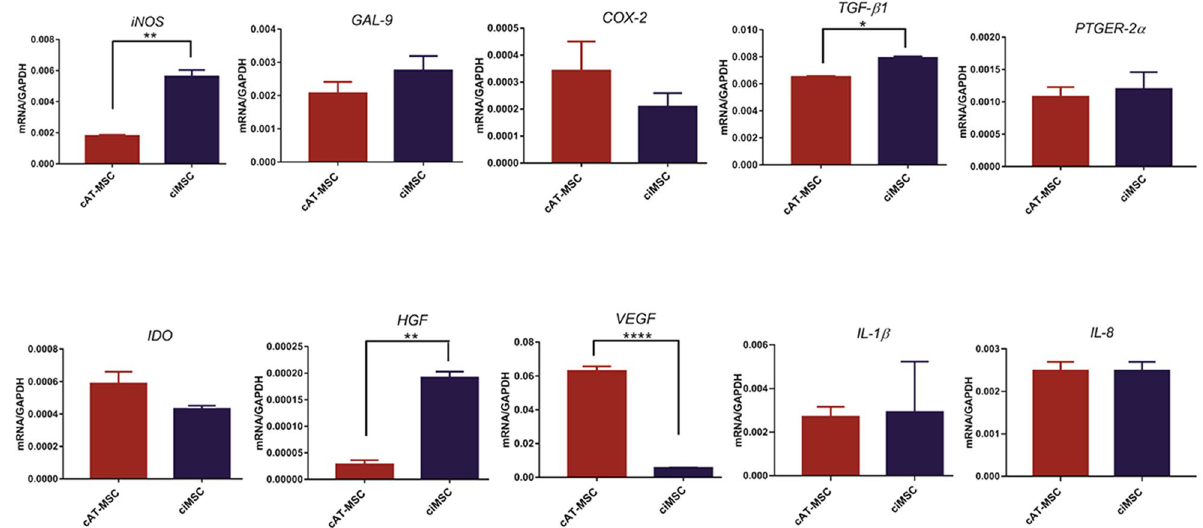
Figure 2. ciMSCs and cAT-MSCs constitutively express immunomodulatory and anti-inflammatory factors. ciMSCs and cAT-MSCs have similar constitutive expression profiles, although ciMSCs express higher levels of iNOS and HGF , and lower levels of VEGF, than the cAT-MSCs. Inducible nitric oxide ( iNOS ); Indoleamine 2,3 dioxygenase ( IDO ); Galectin-9 ( GAL-9 ); Cyclooxygenase-2 ( COX-2 ); Transforming growth factor-β1 ( TGF-β1 ); Prostaglandin receptor-2α ( PTGER-2α ); Hepatocyte growth factor ( HGF ); Vascular endothelial growth factor ( VEGF ) ; Interleukin-8 ( IL-8 ) and Interleukin-1β ( IL-1β ). Significance is defined as: ns = not significant p > 0.05; * p ≤ 0.05; ** p ≤ 0.005; *** p ≤ 0.0002; **** p ≤